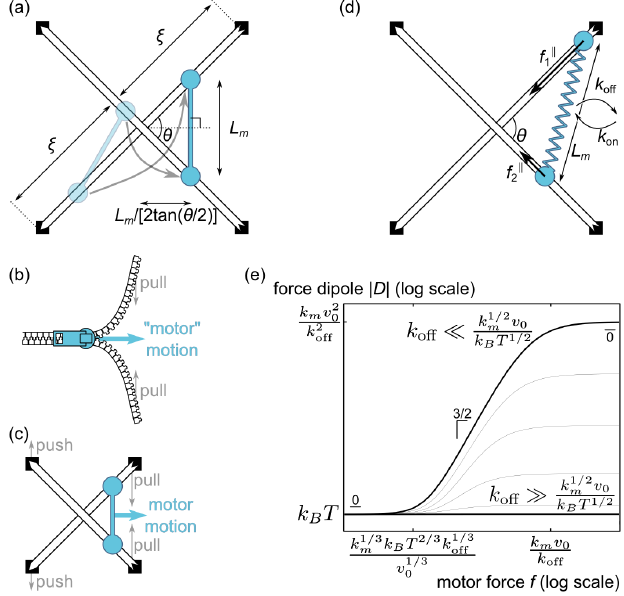
FIG. 3. Contraction induced by finite-size and deformable motors. (a) A finite-size motor minimizes the pseudoenergy [Eq. (6)] by orienting itself perpendicular to the bisector of the filaments (dotted line) as shown by the gray arrows. (b) The contractility induced by such a motor is analogous to the closing force (thin gray arrows) of a zipper when its slider is being slid shut (thick cyan arrow). (c) In practice, the zipperlike pulling forces exerted at the barbed end cross-links are partially com- pensated by pointed end pushing forces. (d) An attaching- detaching flexible motor generates contractility in a similar fashion. (e) Scaling regimes for the deformable motor dipole [Eq. (10)]. Black lines present the limits of small (top curve) and large (bottom curve) detachment rate k and thin gray lines off display intermediate